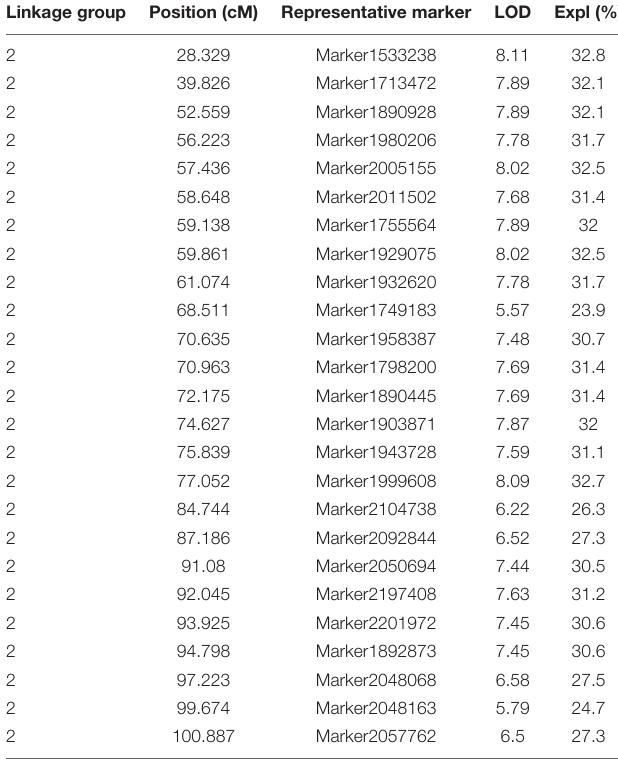
TABLE 2 | Summary of the information of 25 representative markers (potential